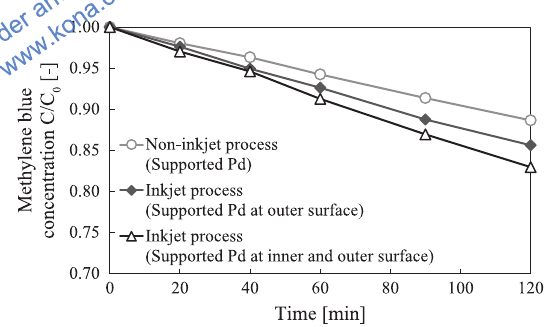
Fig. 11 Change in methylene blue concentration of three types of tita- nia particles prepared under different conditions. Reprinted with per - mission from Ref. (Tanaka et al., 2016). Copyright: (2016) Elsevier.